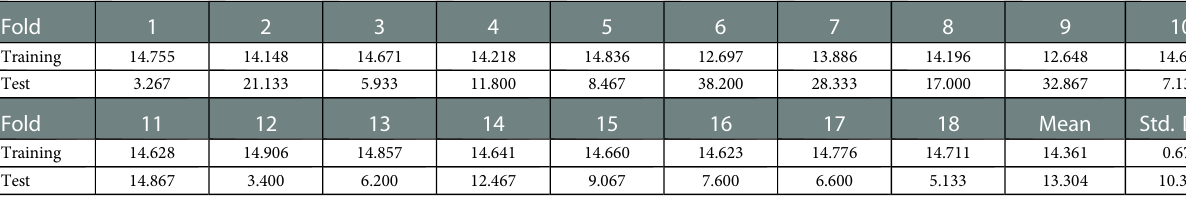
Table 5 Evaluation of training and test data with k-NN.